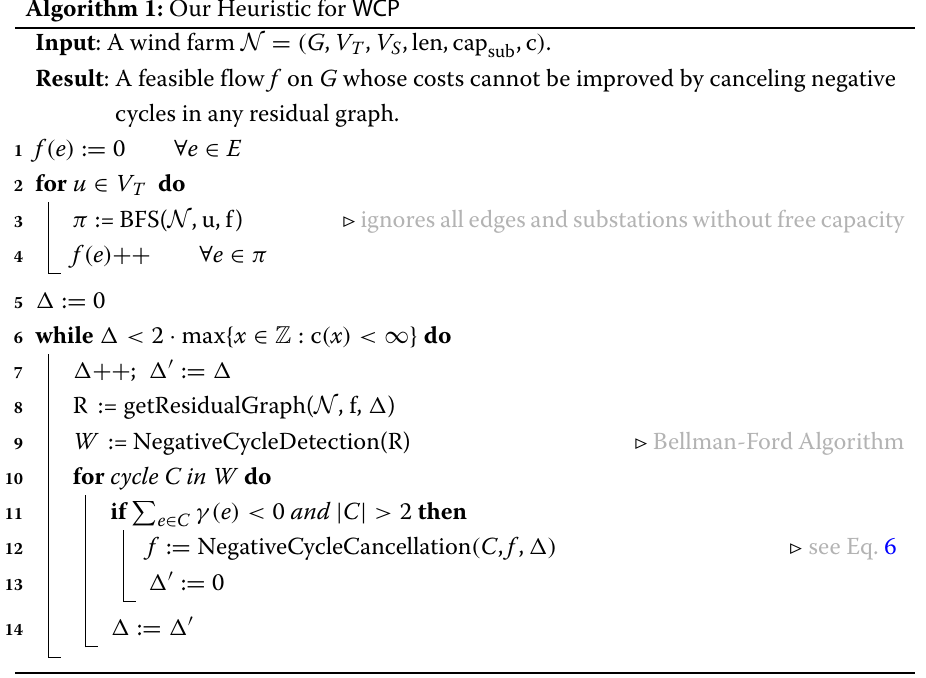
Algorithm 1: Our Heuristic for